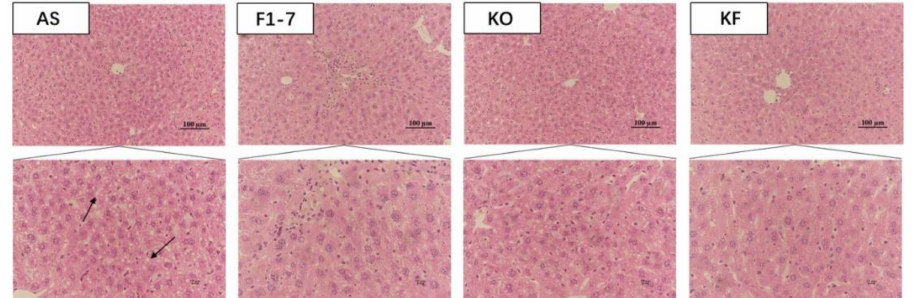
Figure 2. The representative photographs for H&E staining in the livers of mice (n = 4). Scale bar: 100 µ m. The arrow points to the fat droplets.